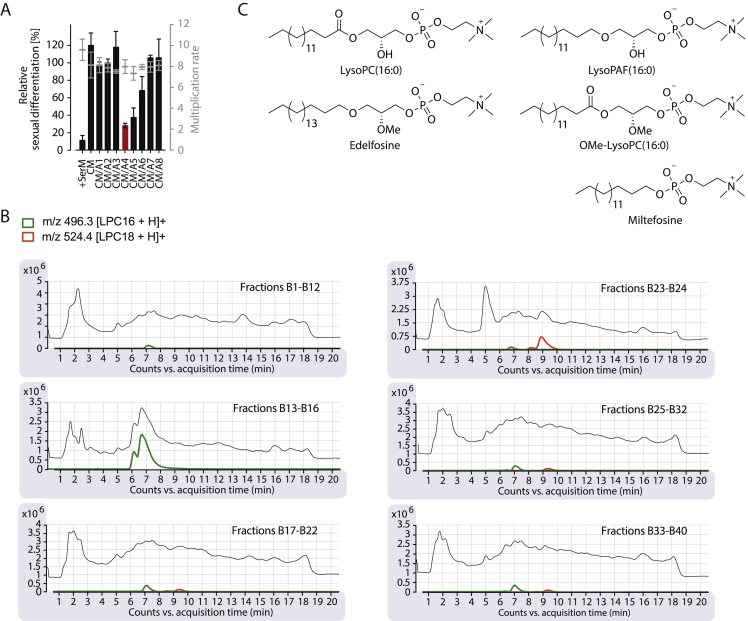
Related to Figure 2(A) Stepwise fractionation of serum (fractions A1–A8) identifies LysoPC as the active component. See Figure 2A for schematic of experimental approach. Bars quantify sexual differentiation normalized to a −SerM- or CM-exposed control population. Active fractions were tested in biological triplicates or quadruplicates as described (Brancucci et al., 2015). Data from a representative experiment is shown and standard deviations of technical triplicates are indicated. CM, 80% conditioned medium.(B) LC-MS chromatograms and mass spectra of B fractions (see above) are shown; LysoPC species are highlighted in color.(C) Chemical structures of tested analogs.